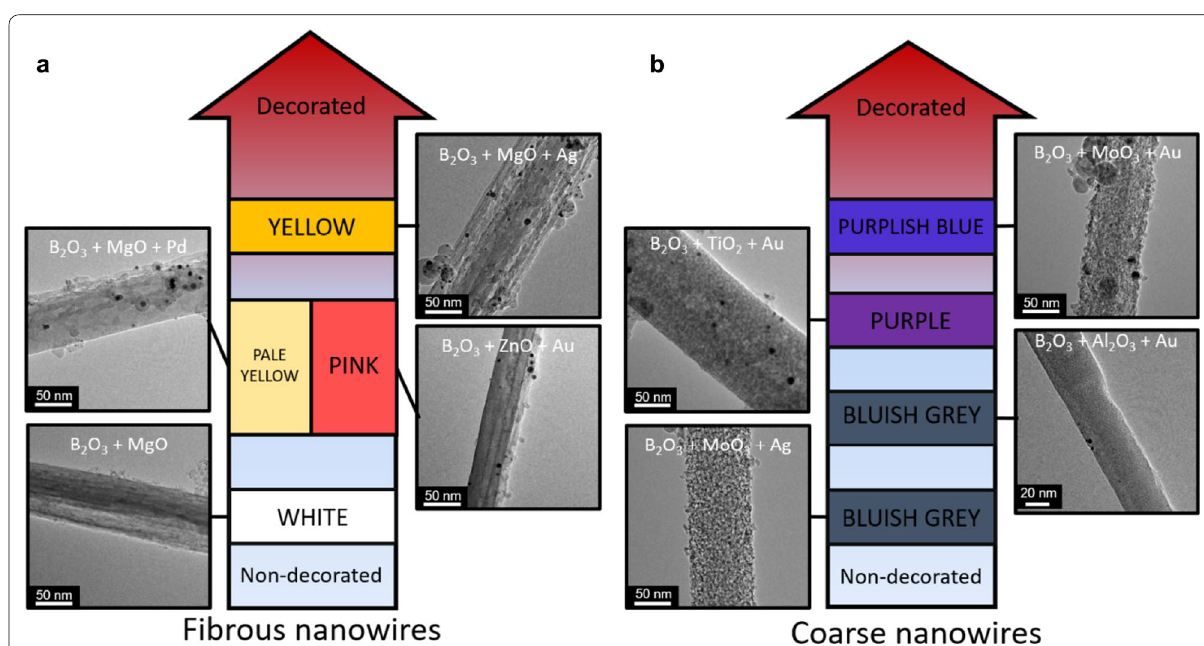
Fig. 4 Degree of decoration of various nanowires. a Graphic representation of a qualitative scale of the degree of decoration of the fibrous nanowires. Four different types of nanowires have been selected as representative examples. Nanowires without decoration are placed near the base of the arrow as it is the case of B 2 O 3 :MgO nanowires. As the nanowires are gradually decorated with more nanoparticles they are placed higher in the arrow. The color of the boxes along the arrow matches the color of the macroscopic amounts of each type of nanowire. b An analogous type of graphic but for the case of nanowires with a coarse surface